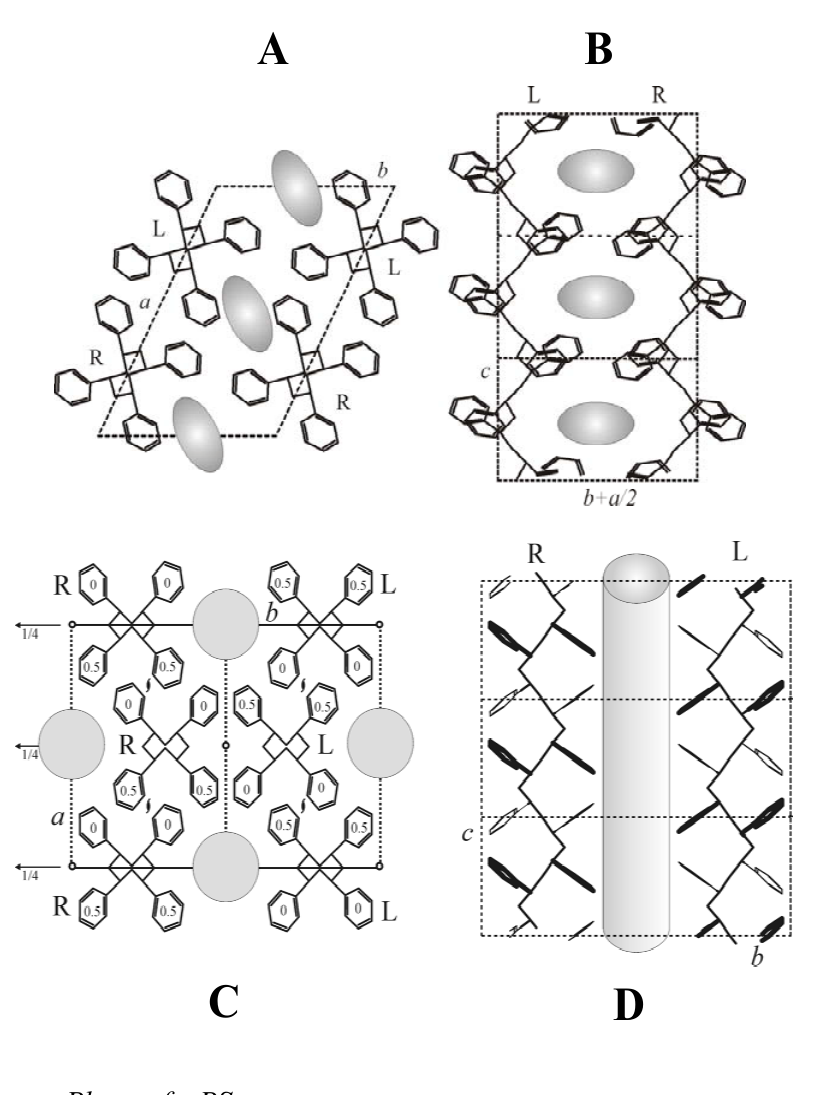
Figure 2. Top and lateral views of the crystalline structures of the two nanoporous crystalline phases of s-PS: for the δ (upper figures) and ε (lower figures) phases, the porosity is distributed as cavities and channels,